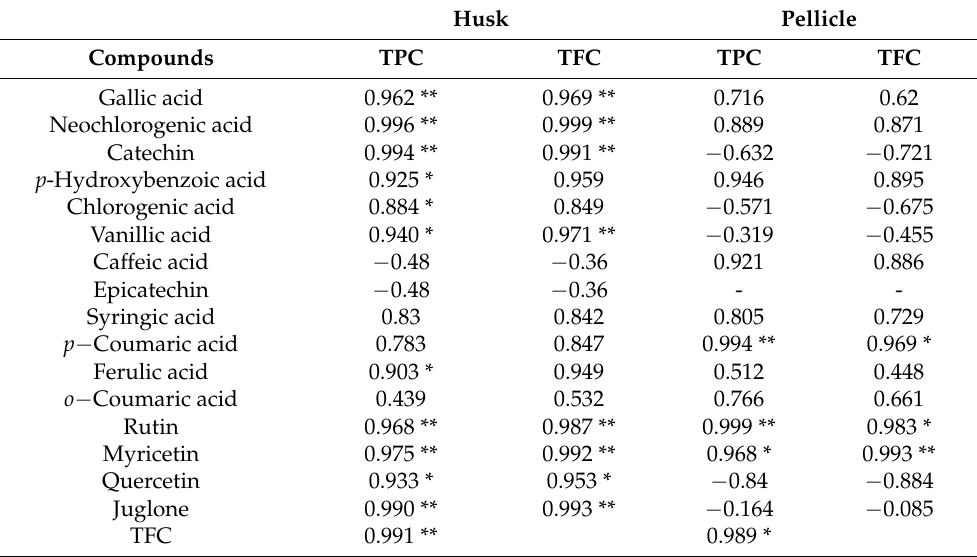
Myricetin 0.975